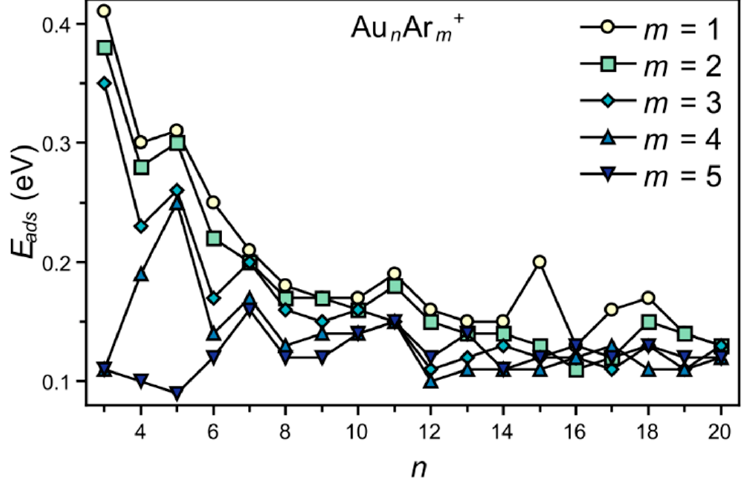
Figure 4. Adsorption energies of the m th adsorbed Ar atom in the Au n Ar m + clusters, calculated using Equation (1).